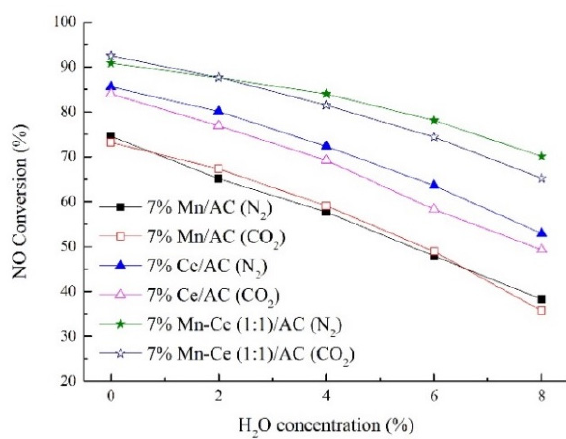
Figure 9. NH 3 -SCR using different H 2 O concentrations under CO 2 and N 2 atmosphere. Other conditions: temperature 250 °C; 800 ppm NO; 800 ppm NH 3 ; 6% O 2 ; 0 ppm SO 2 and space velocity 3408 h − 1 .